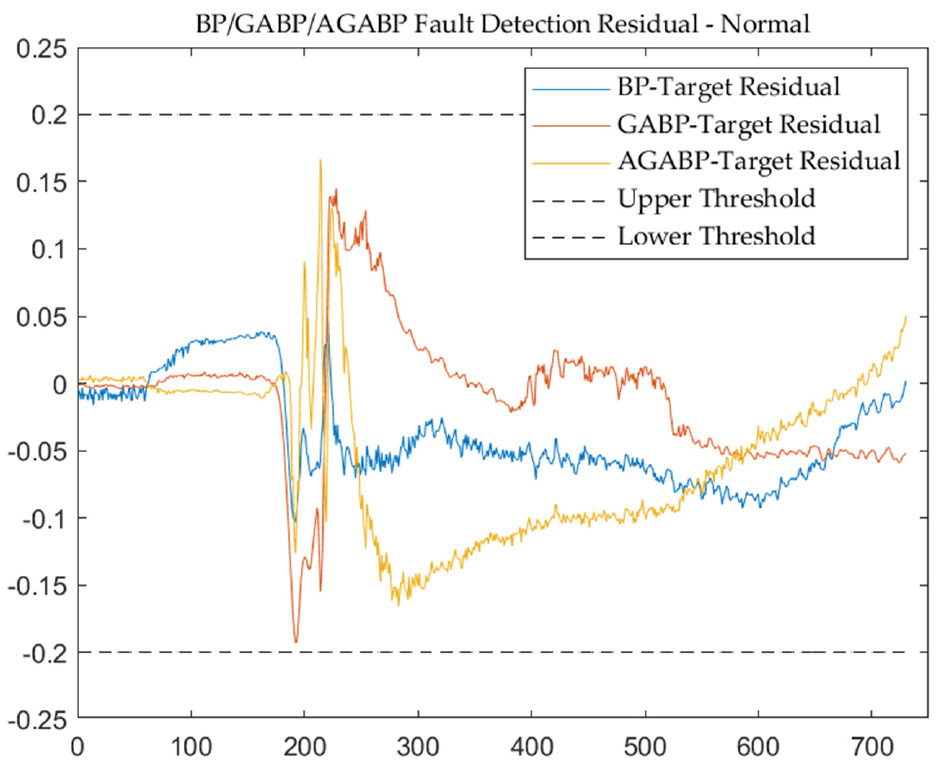
Figure 9. The output residuals of the three models—normal.